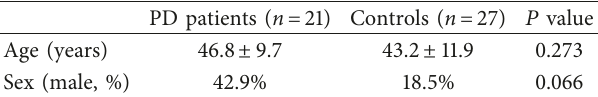
Table 1: Age and sex of peritoneal dialysis (PD) patients and controls.